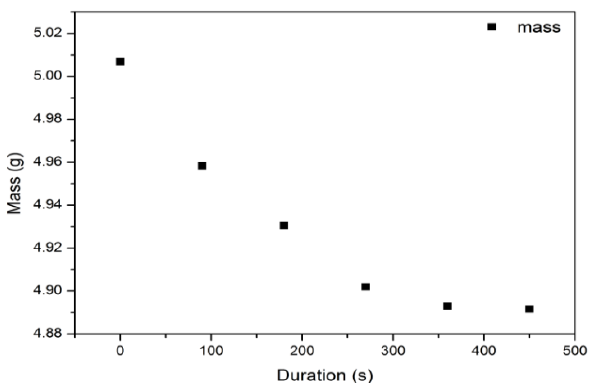
Figure 1. Mass loss of octadecyltrimethylammonium (ODTMA)–clay sample under microwave (MW) irradiation.